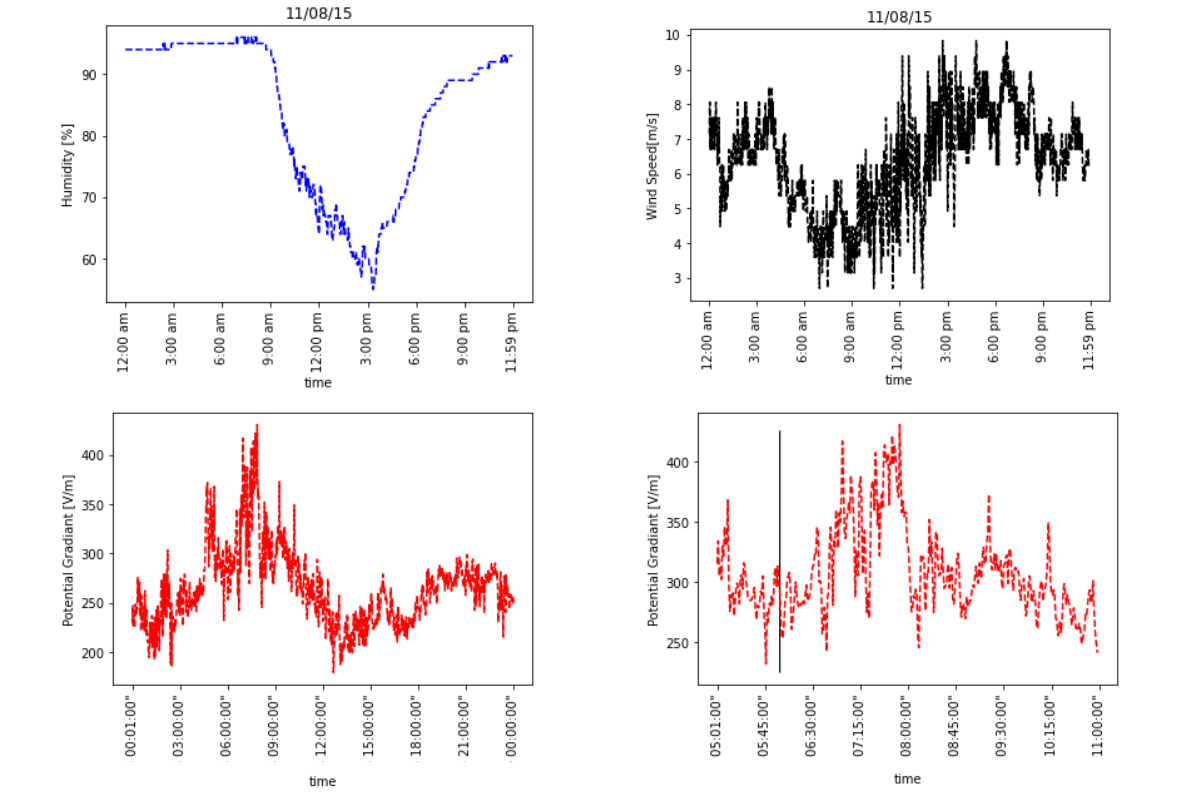
Figure 4. Data for the 8 November 2015 fog case study. Hourly values of relative humidity ( top left ), wind speed ( top right ), daily PG ( bottom left ), and hourly 5:00–11:00 PG ( bottom right ). The vertical black line is sunrise time 6:00 LT.